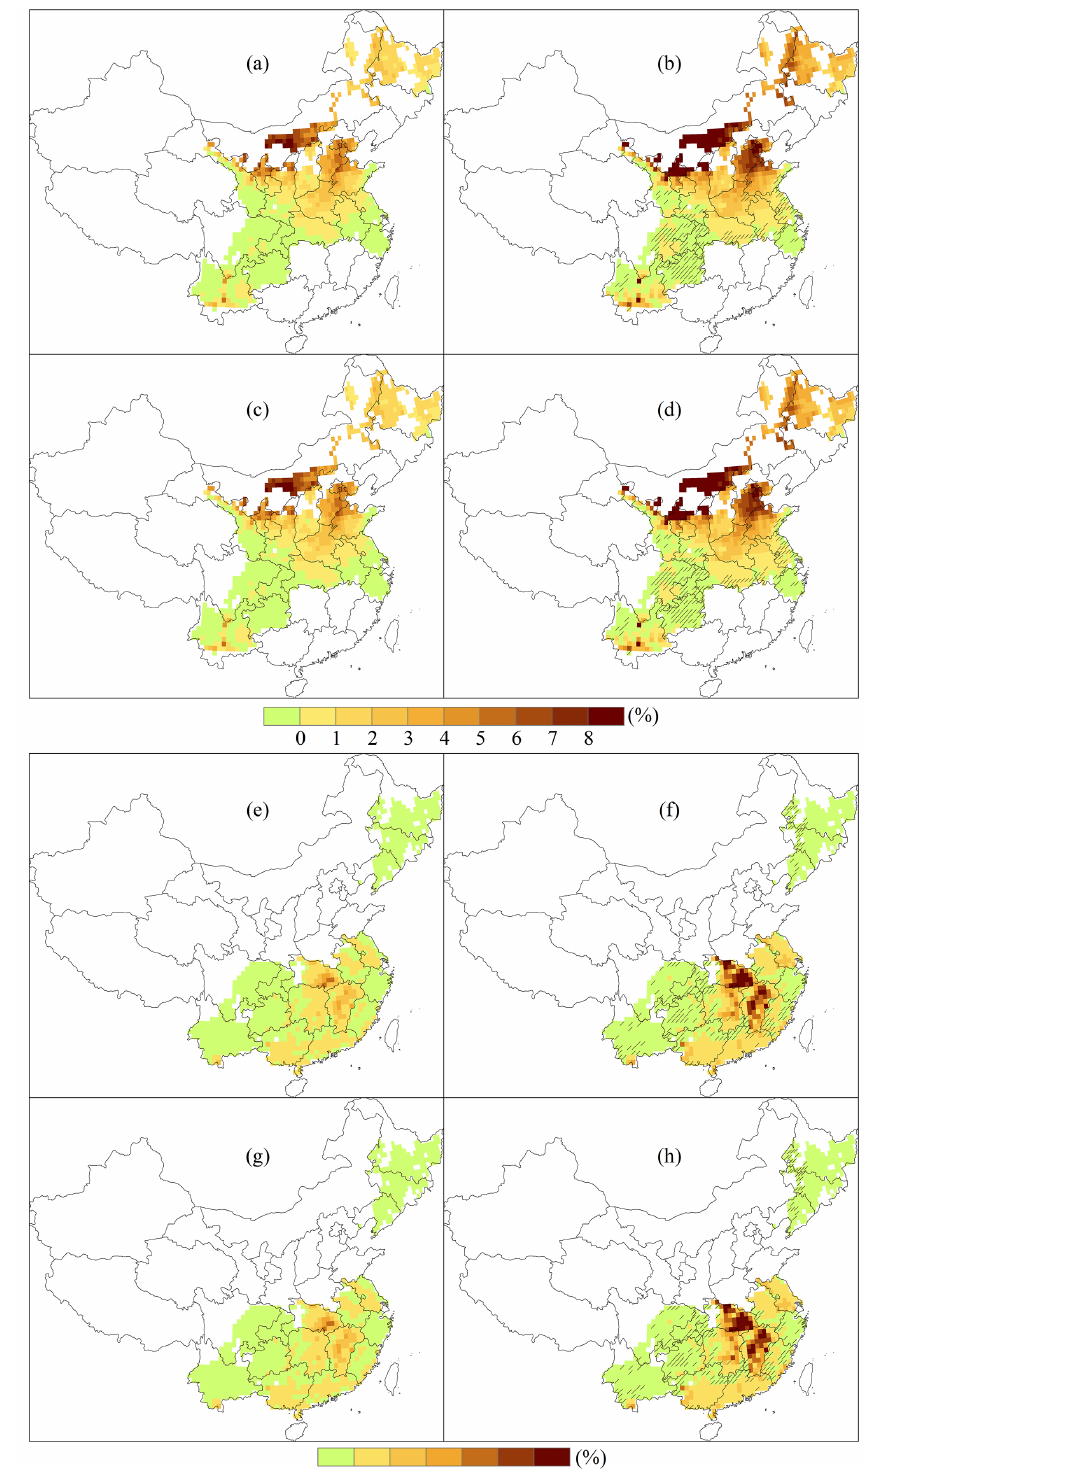
Figure 7. Median changes in yield loss caused by heat stress for wheat (a–d) and rice (e–h) during 2106–2115 under the 1.5 ◦ C warm- ing (a, c, e, g) and 2.0 ◦ C warming (b, d, f, h) scenarios relative to 2006–2015, without (a, b, e, f) and with (c, d, g, h) the CO 2 fertilization effect. Hatching indicates the areas where differences between the 1.5 and 2.0 ◦ C warming scenarios are not significant ( P > 0 .